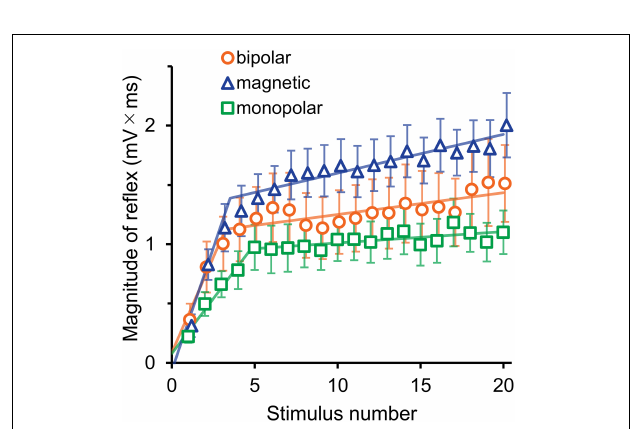
FIGURE 3 | Experiment 1. The mean magnitude ± SE of the reflex for 20 consecutive stimulations is plotted against the stimulus number. The lines show the results of segmented linear regression